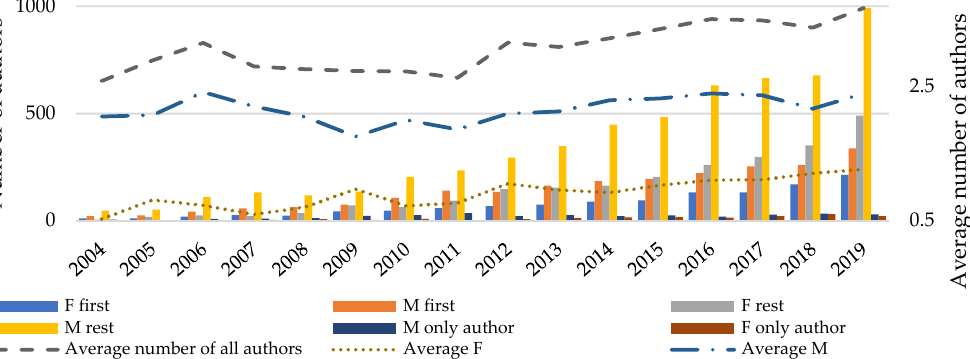
Figure 4. Gender distribution and collaborative patterns. Source: Authors; N = 11,544. Note: M/F rest—all authors male/female except the first author.